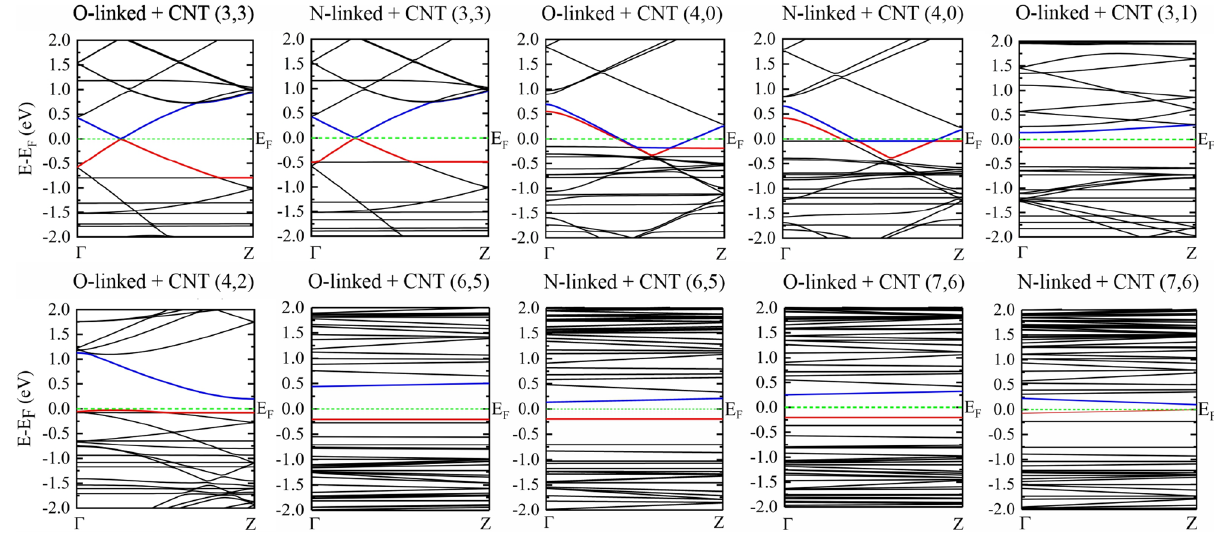
Figure 5. Band structure of semiconductor CNTs in the presence of glycan molecules. Valence and conduction bands are represented in red and blue colours, respectively. Fermi energy E F is set to